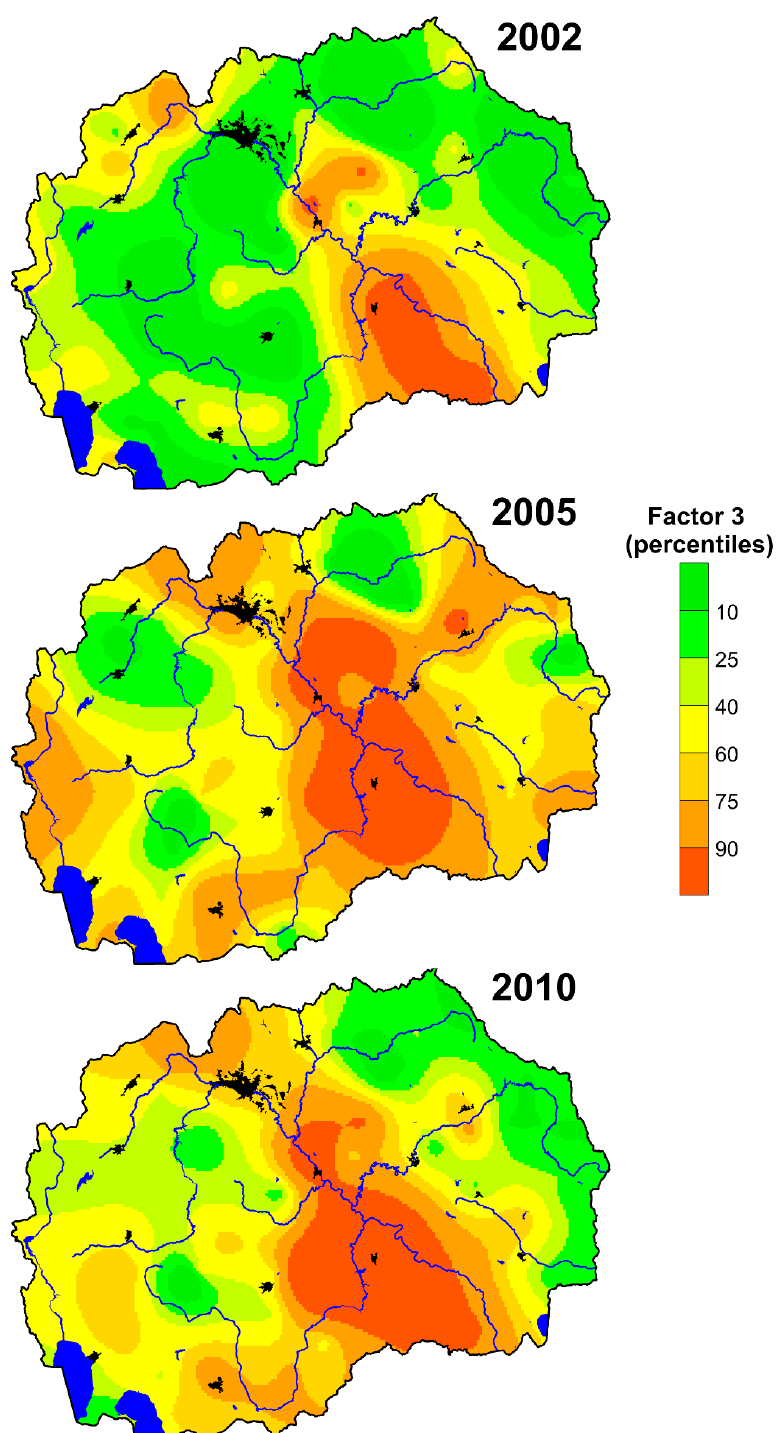
Figure 8. Spatial distribution of F3 factor scores (Ni-Cr).